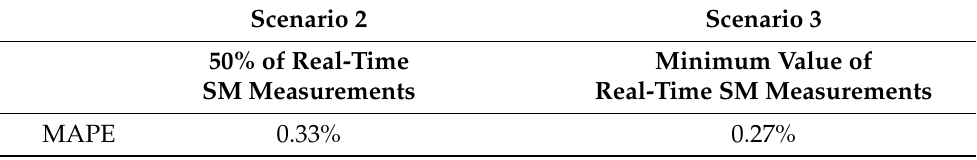
Table 10. Scenario 2 and 3 mean absolute percentage errors results for the state estimations.